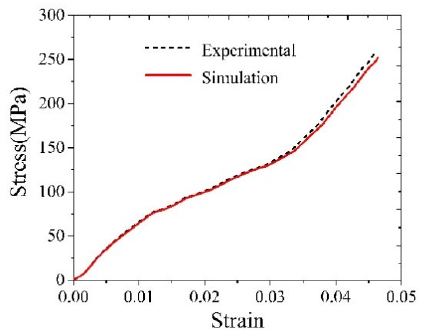
Figure 15. The experimental and finite element simulation stress-strain curve during conventional tensile strength.